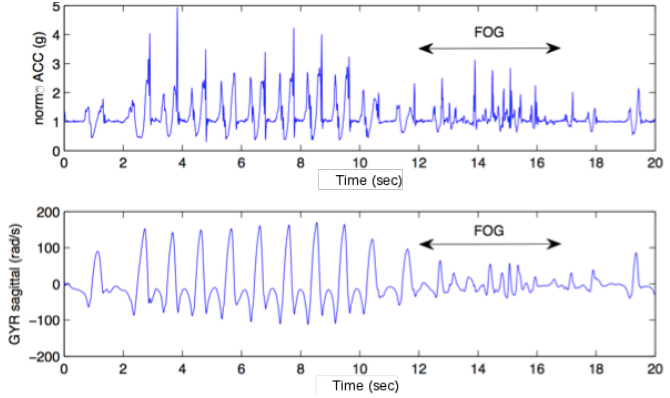
Figure 2. Example of FOG episode observed through an IMU